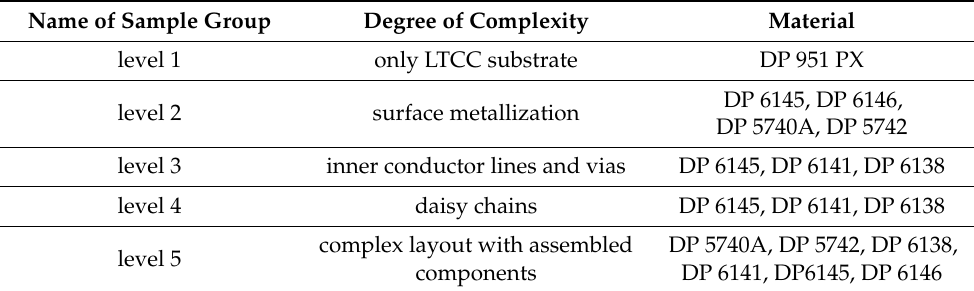
Table 1. Overview of the different technological stages and used